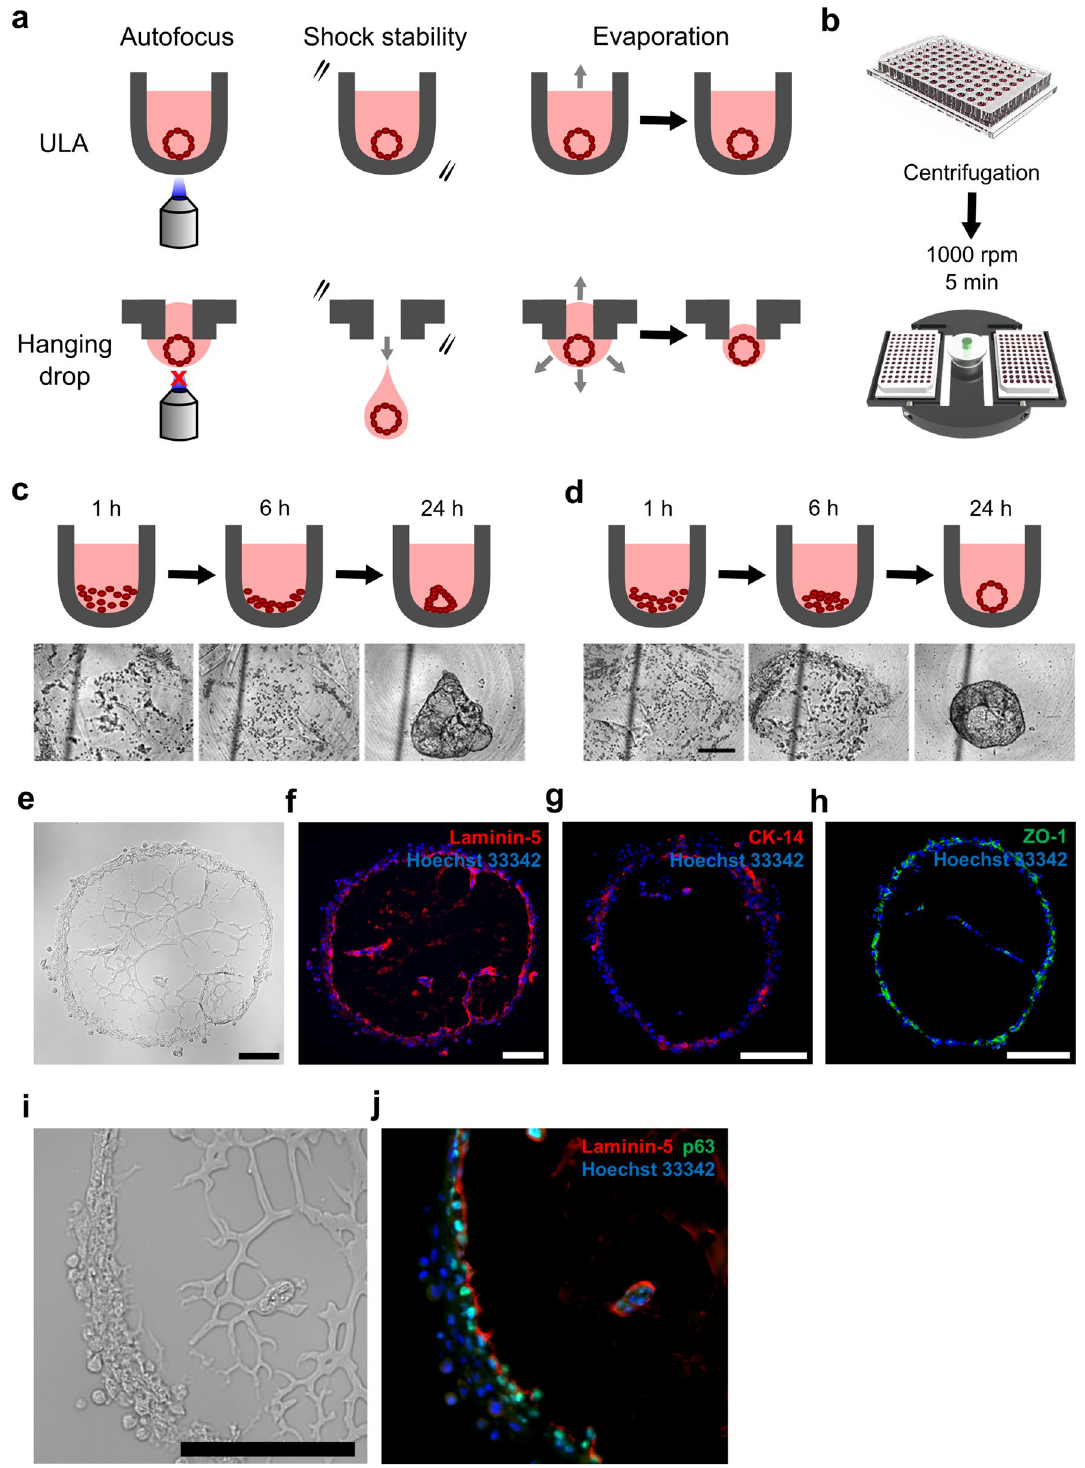
Figure 1. 384-well ultra-low attachment (ULA) plates combined with centrifugation allow for basal-in mammary organoid formation. ( a ) The ULA plate format provides several key advantages over hanging drop: (1) compatibility with autofocusing microscopy systems, (2) increased resistance to physical disturbances, and (3) reduced evaporation. ( b ) Schematic showing 384-well ULA plate centrifugation at 1000 rpm (142 rcf) for 5 min. ( c ) Schematic and images of cell-Matrigel suspension in a ULA well without centrifugation. ( d ) Schematic and images of ULA well with centrifugation. Scale bar represents 400 μm. ( e – j ) Brightfield and immunofluorescence images from sections of day 16 organoids formed in the 10 ng/mL EGF and 120 µg/mL Matrigel. All scale bars represent 150